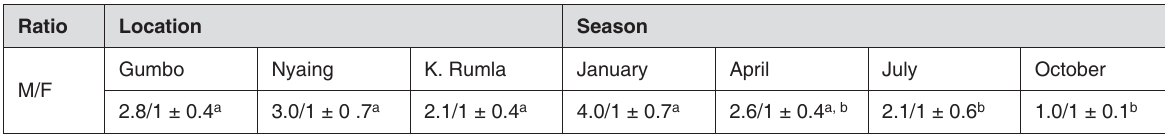
(Table 5). Data on distribution, abundance, season- ality and correlation between mean tick count and climatic factors are presented separately below for